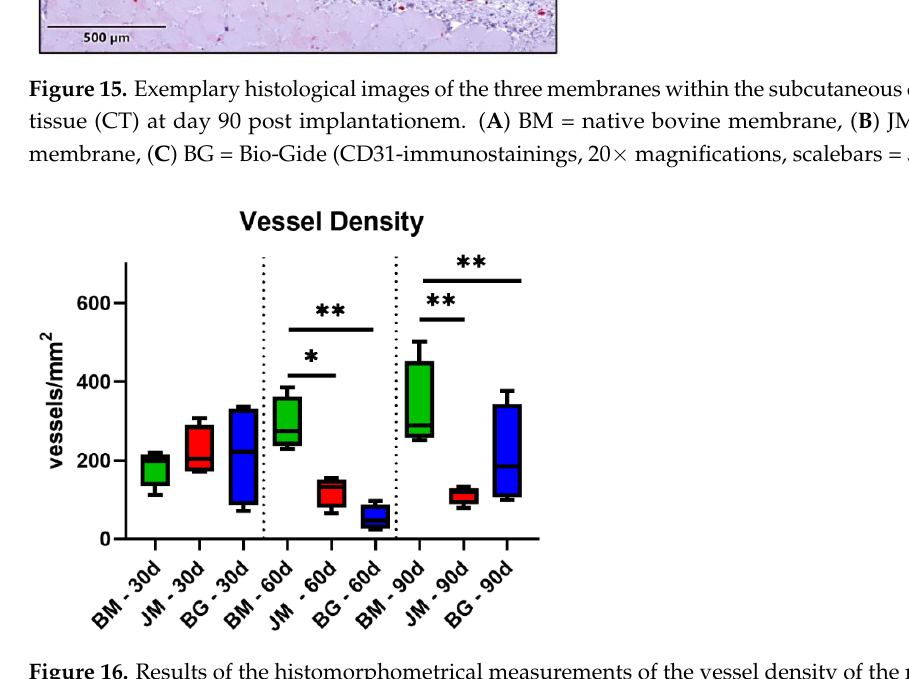
Figure 16. Results of the histomorphometrical measurements of the vessel density of the areas (* = intraindividual differences; *: p < 0.05 and **: p < membrane areas (* = intraindividual differences; *: p < 0.05 and **: p < 0.01).